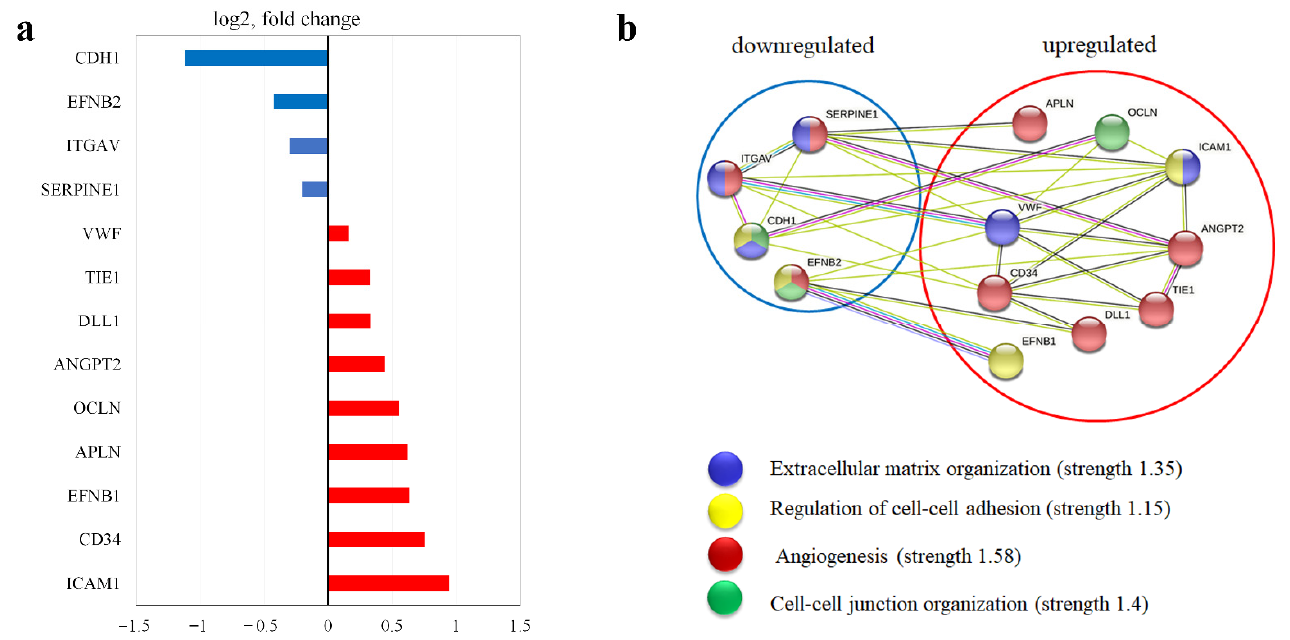
19 of 28 Figure 7. EM synthesis. HUVECs were grown on Matrigel TM ( a ), as proliferating/motile HUVECs, in co-culture with MSCs ( b ), or as a confluent monolayer for 19 h. Cells in direct co-culture were separated using anti CD31 magnetic beads. Total RNA was isolated and specific mRNA levels were quantified by qRT PCR as described in “Methods”. The data are presented as fold changes in the mRNA levels of HUVECs on Matrigel TM , in co-culture with MSCs, proliferating/motile HUVECs compared to the mRNA levels for the same transcript in confluent monolayer, or to a monoculture for MSCs “*”: p < 0.05, n ≥ 3. ( c ) HUVECs were preloaded with CMFDA before being placed in direct co-culture. Cells were grown for 48 h, washed, fixed with 4% PFA, and stained with anti-fibronectin,